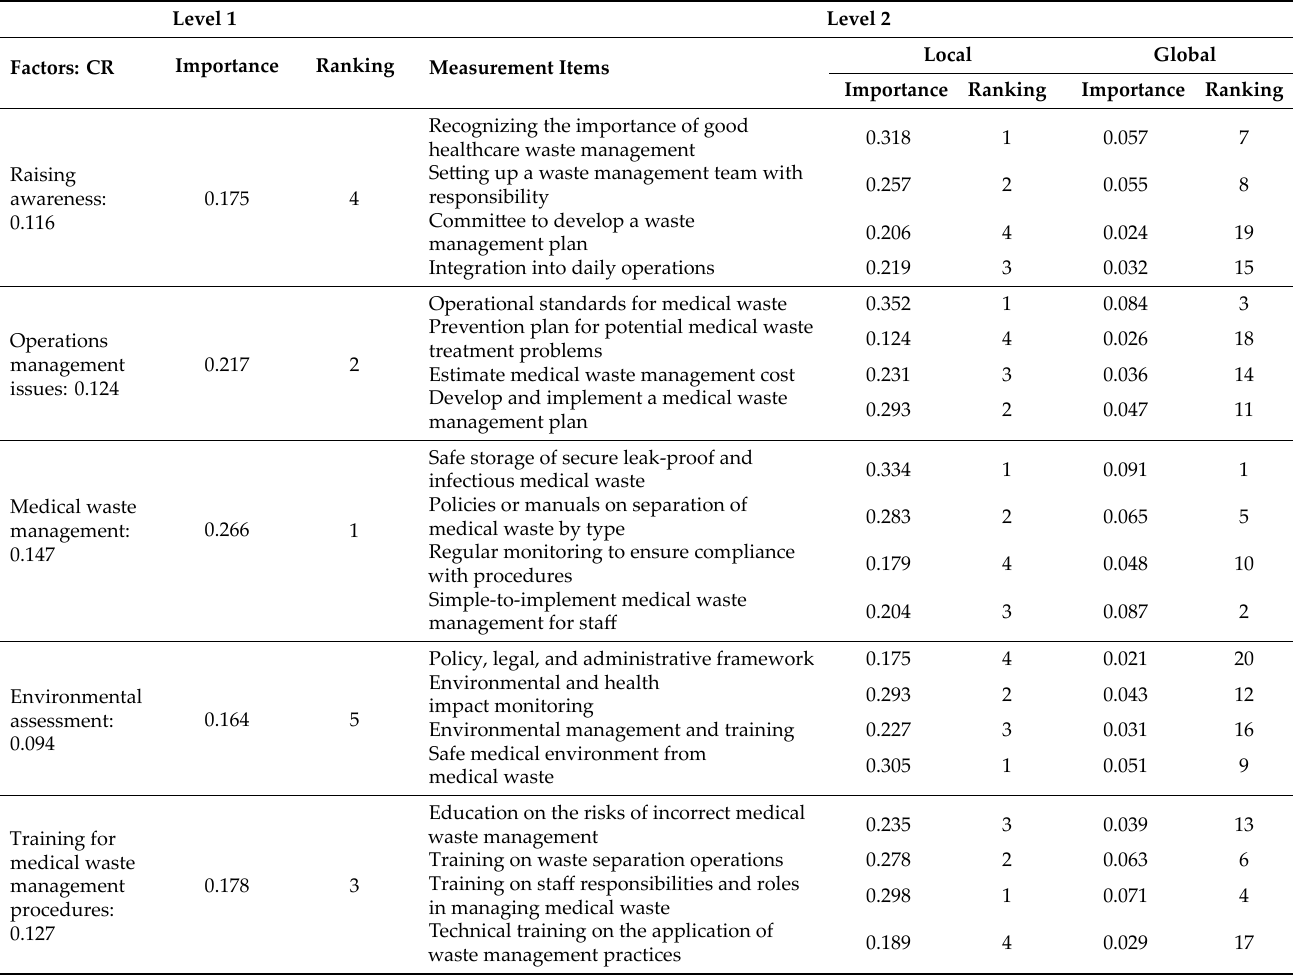
Table 5. Results of the pairwise comparison